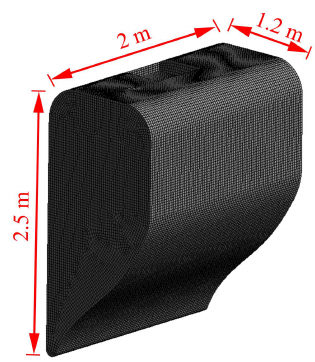
Figure 3. The finite element model of buoy in AQWA.